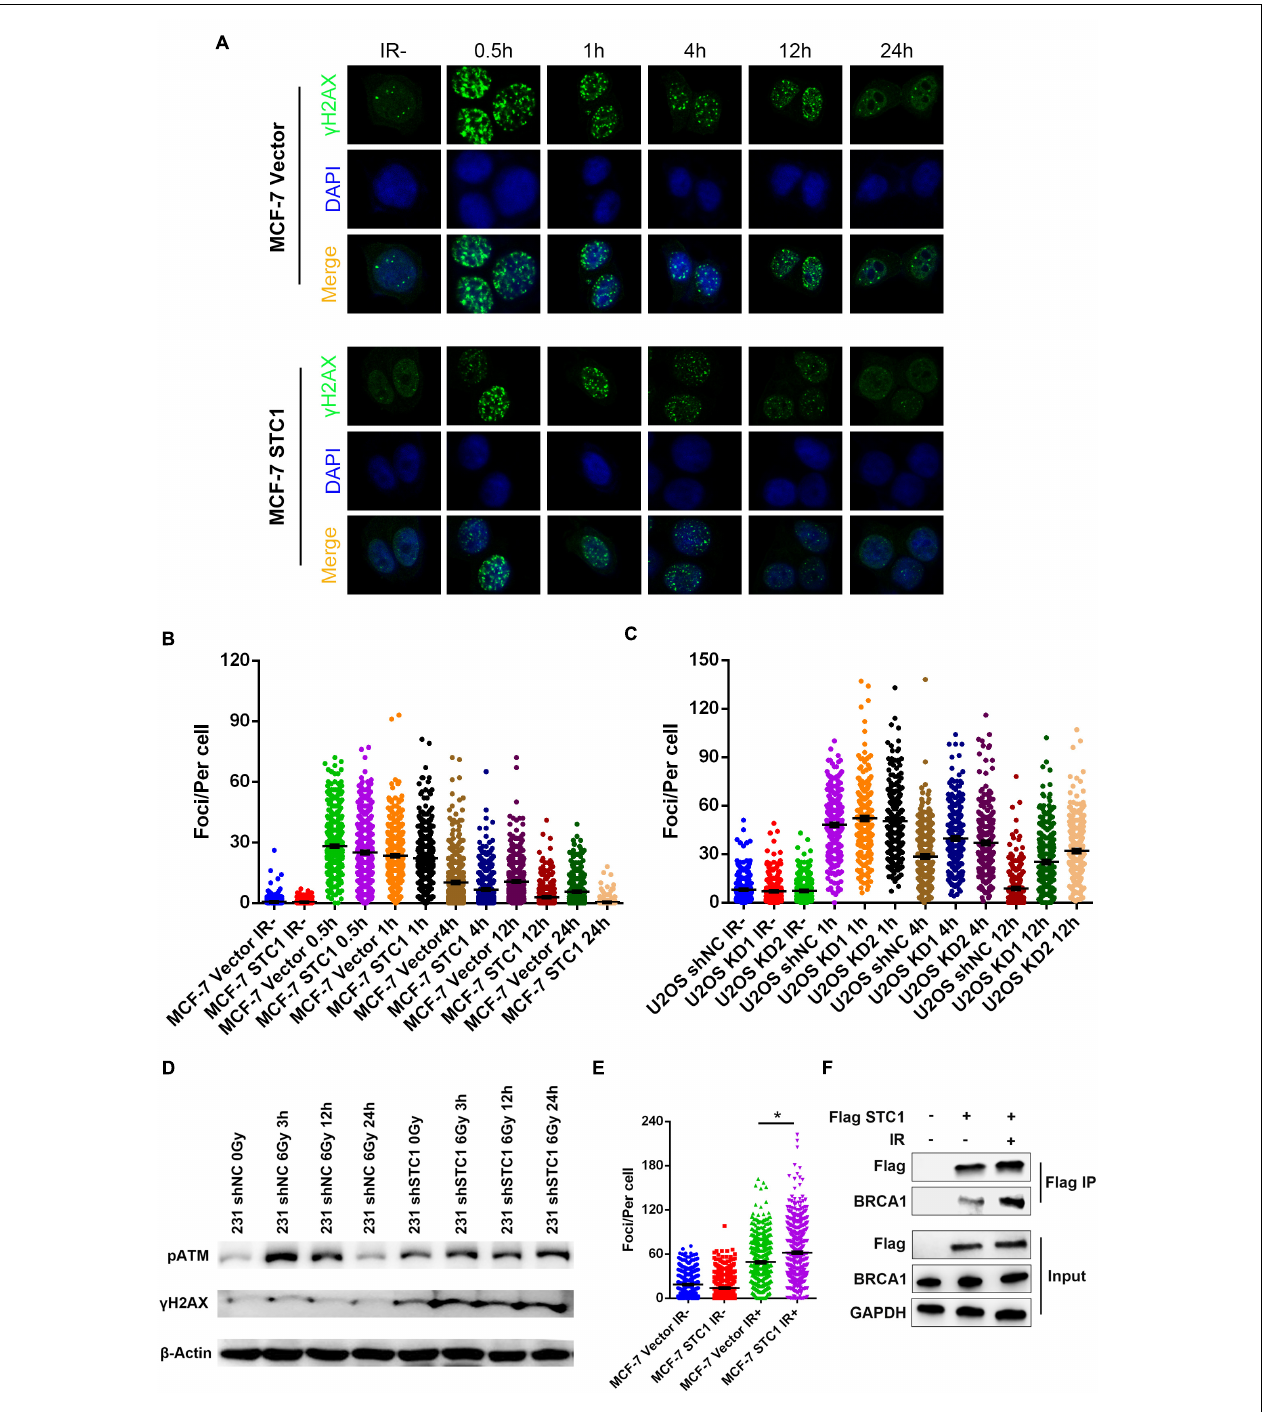
FIGURE 5 | STC1 facilitates homologous recombination in a BRCA1-mediated manner. Representative images (A) and quantification of γ H2AX foci in MCF-7 STC1 cells and their corresponding control cells (B) or U2OS cells stably expressing STC1 shRNA and their control cells (C) . Cells were treated with IR (2 Gy) at different time points and then were subjected to immunofluorescence with γ H2AX antibody. The number of γ H2AX was determined by ImageJ. (D) Immunoblot analysis of phosphorylation of ATM and H2AX in 231 shSTC1 cells and their control cells with or without IR. (E) Quantification of BRCA1 foci in MCF-7 STC1 cells and their corresponding control cells treated with IR (2 Gy) at 4-h time point. (F) The 293T cells were transfected with Flag-STC1 or vector and then treated with IR (10 Gy). One hour later, the cells were lysed and immunoprecipitated with anti-Flag agarose beads. The beads were boiled and blotted with indicated antibodies. P -value was determined by two-tailed unpaired t -test (* P <